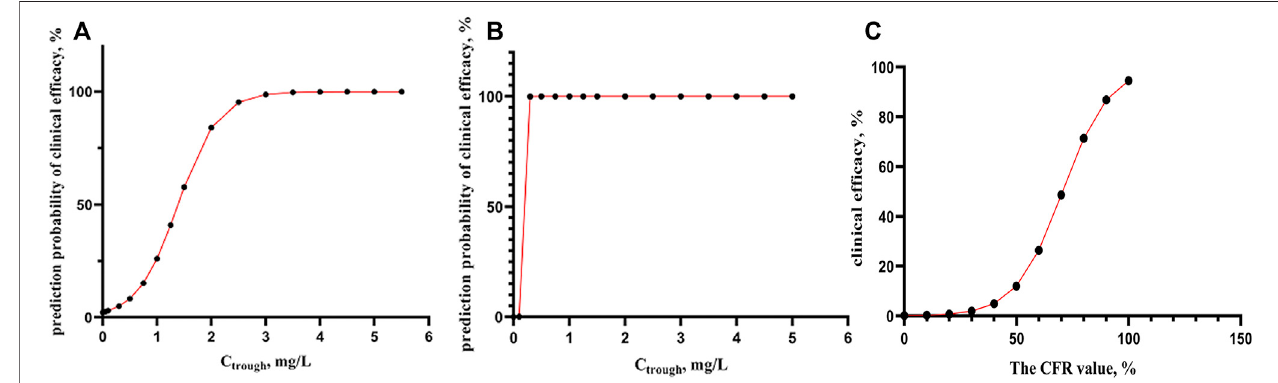
FIGURE 2 | (A-B) the correlation between predict probability of clinical ef fi cacy and C though , for prevention and treatment of aspergillus fumigatus and candida infection using logistic regression analyses ( n (cid:1) 35). (C) The correlation between the actual clinical ef fi cacy and CFR value of fAUC ss /MIC using logistic regression analyses ( n (cid:1)